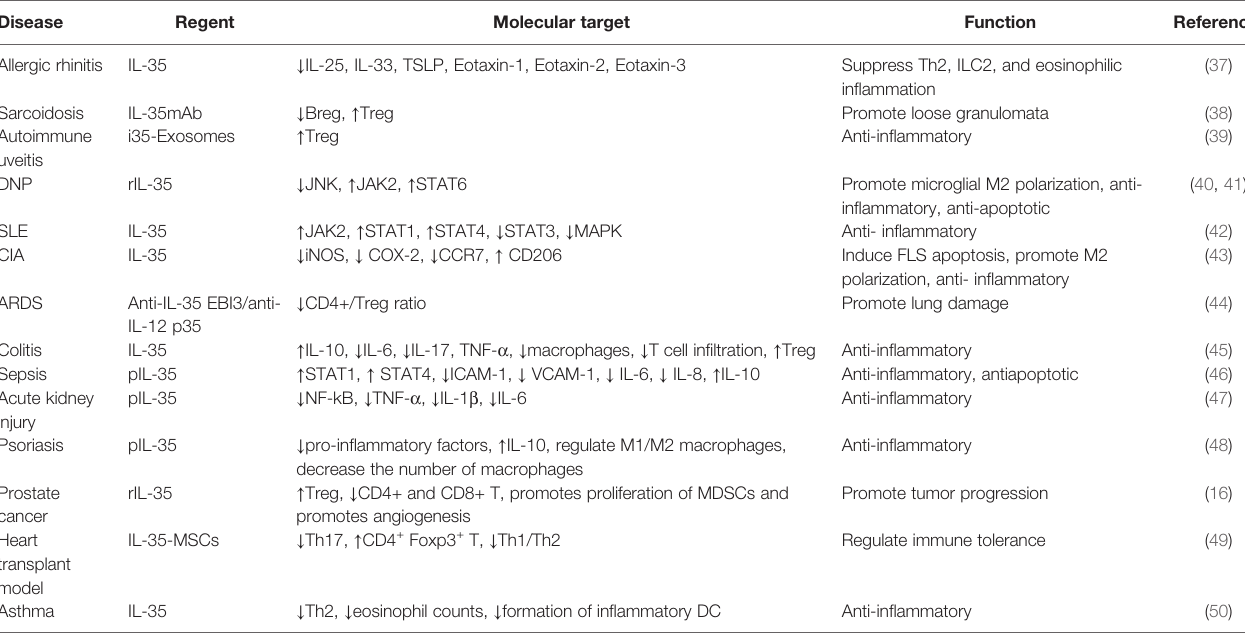
TABLE 1 | The role of IL-35 in disease mouse models. Disease Regent Molecular target